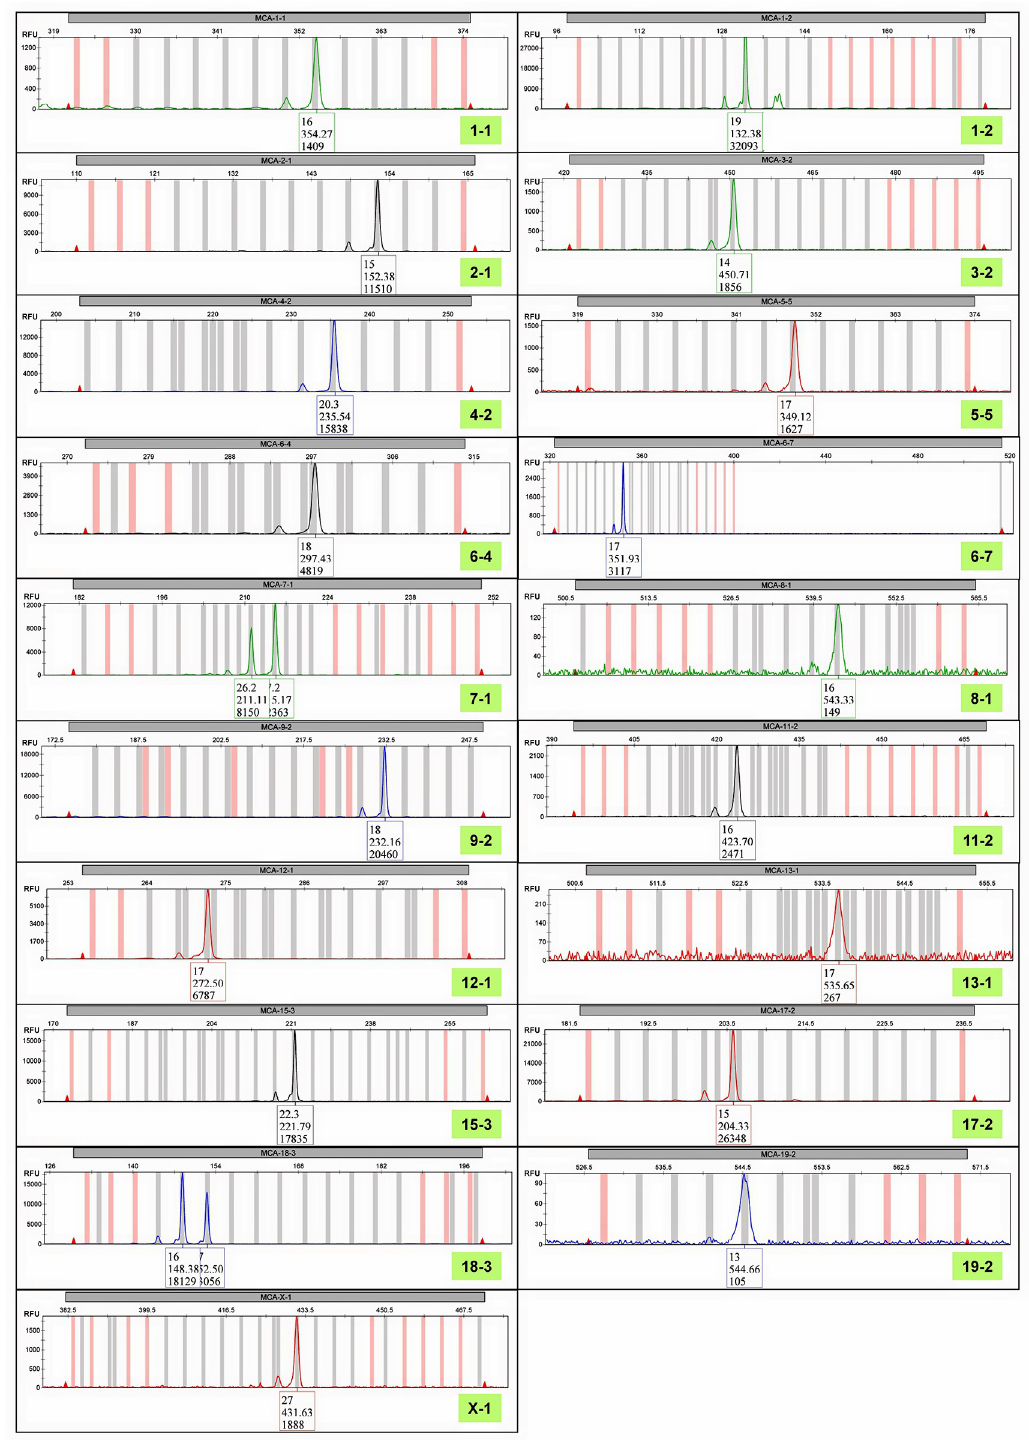
Fig 1. Electropherograms for Col-GFP HSC resulting from analysis of 19 consensus markers. DNA from Col-GFP HSC cells was isolated and the genetic profile determined using the STR markers 1–1, 1–2, 2–1, 3–2, 4–2, 5–5, 6–4, 6–7, 7–1, 8–1, 9–2,